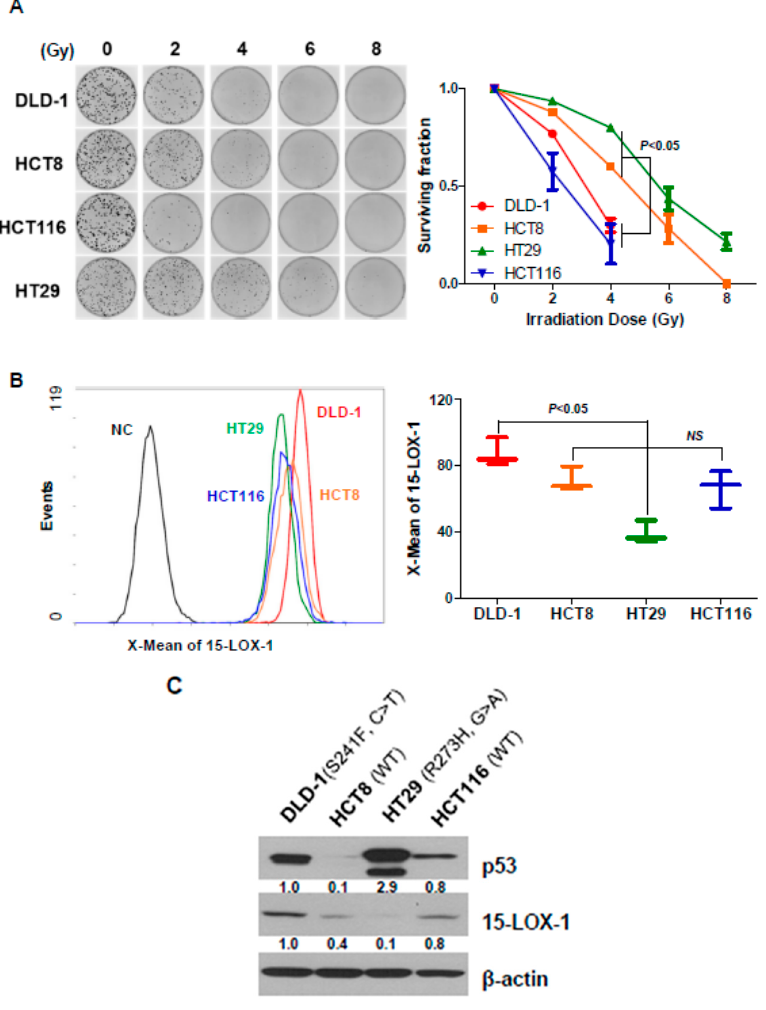
Figure 1. The radiosensitivity of CRC cell lines correlates with 15-LOX-1 expression levels. ( A ) Representative clones and clonogenic cell survival curves of DLD-1, HCT8, HCT-116, and HT29 cells. After seeding, the cells were irradiated at 2, 4, 6, and 8 Gy. The numbers of the colonies generated were counted two weeks later. ( B ) The 15-LOX-1 level of CRC cells was measured by flow cytometry. ( C ) The p53 and 15-LOX-1 levels were analyzed by Western blotting. The functional statuses of p53 in the cell lines are indicated above the results to describe their correlation with the role of 15-LOX-1 in radiation sensitivity.